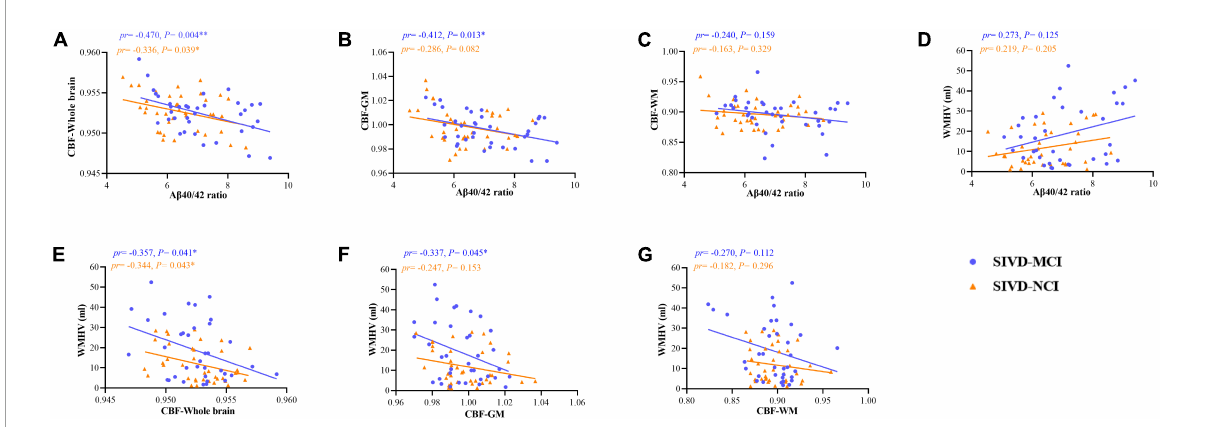
FIGURE3 Scatter plots of correlation between serum A β 40/42 ratio, WMHV, and CBF (including whole brain, GM, and WM) in patients with SIVD-MCI and SIVD-NCI. The blue dots represented the SIVD-MCI group, and the orange-yellow triangle represented the SIVD-NCI group. (A) Negative correlations between serum A β 40/42 ratio and CBF in the whole brain. (B) Negative correlations between serum A β 40/42 ratio and CBF in the GM. (C) Negative correlations between serum A β 40/42 ratio and CBF in the WM. (D) Positive correlations between serum A β 40/42 ratio and WMHV. (E) Negative correlations between CBF in the whole brain and WMHV. (F) Negative correlations between CBF in the GM and WMHV. (G) Negative correlations between CBF in the WM and WMHV. pr, partial correlation coefficient; GM, gray matter; WM, white matter; CBF, cerebral